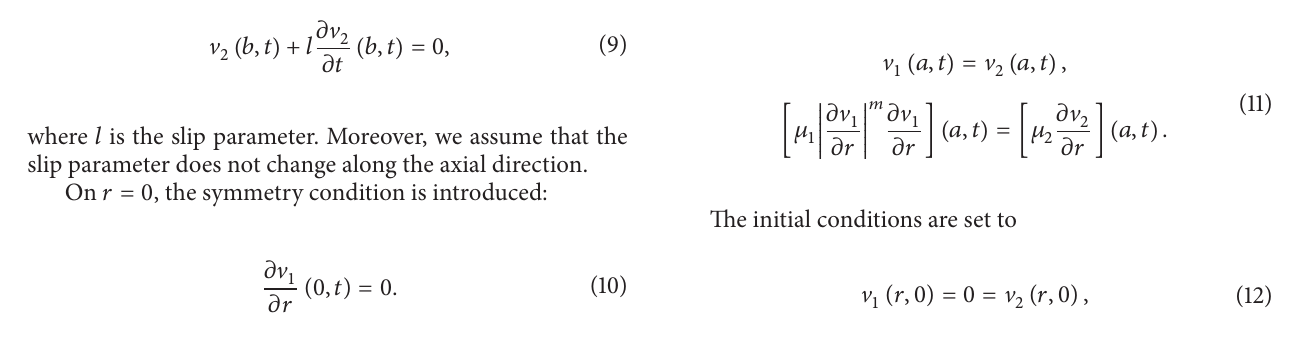
strain rate by 𝜎 𝑟𝑧 = 𝜇 2 (𝜕 V /𝜕𝑧) . Thus, the Navier slip condition can be written